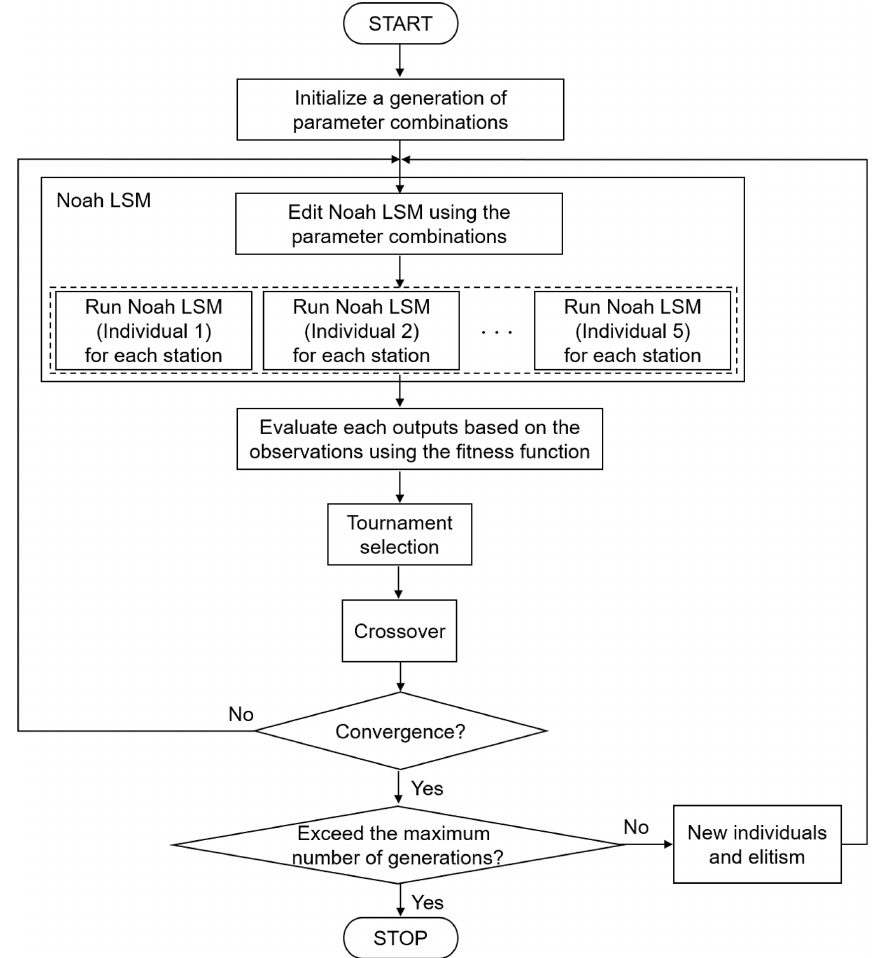
Figure 2. A flowchart of parameter optimization from the micro-GA–Noah LSM coupled system. The dashed box depicts the parallel system for the Noah LSM, running for each